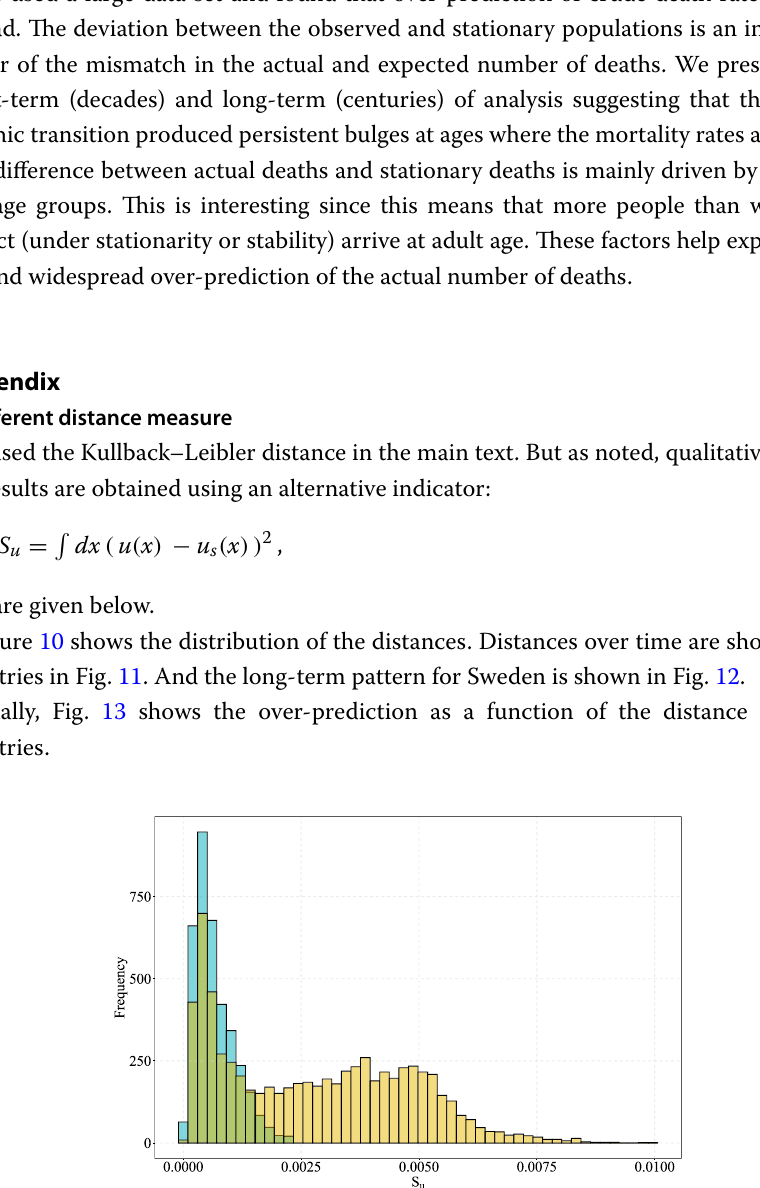
Fig. 10 Frequency of S u value in countries from HMD and WPP. HMD data in green (or blue) and WPP data in